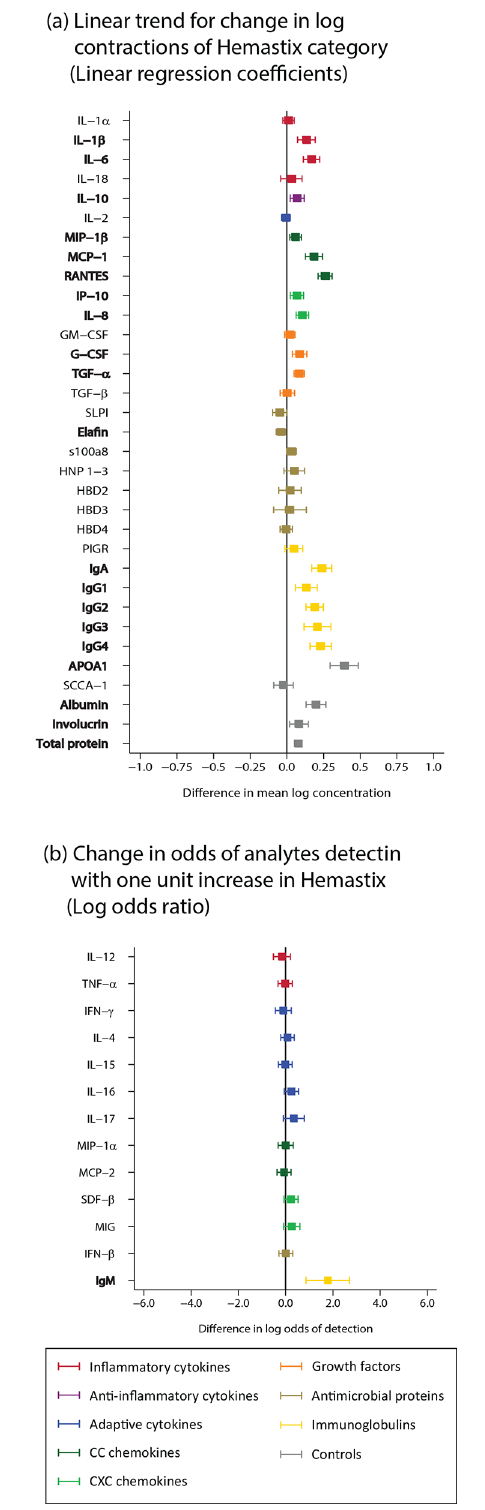
Fig 10. Haemoglobin (n = 369). Haemoglobin was measured by Hemostix test strips in the CVLs, categories were none, low (25 erythrocytes [ery]/ μ L), moderate (80 ery/ μ L), high (200 ery/ μ L). Bolded analytes represent associations with a p-value (cid:1) 0.05. (A) For analytes with > 85% detection using linear regression, linear